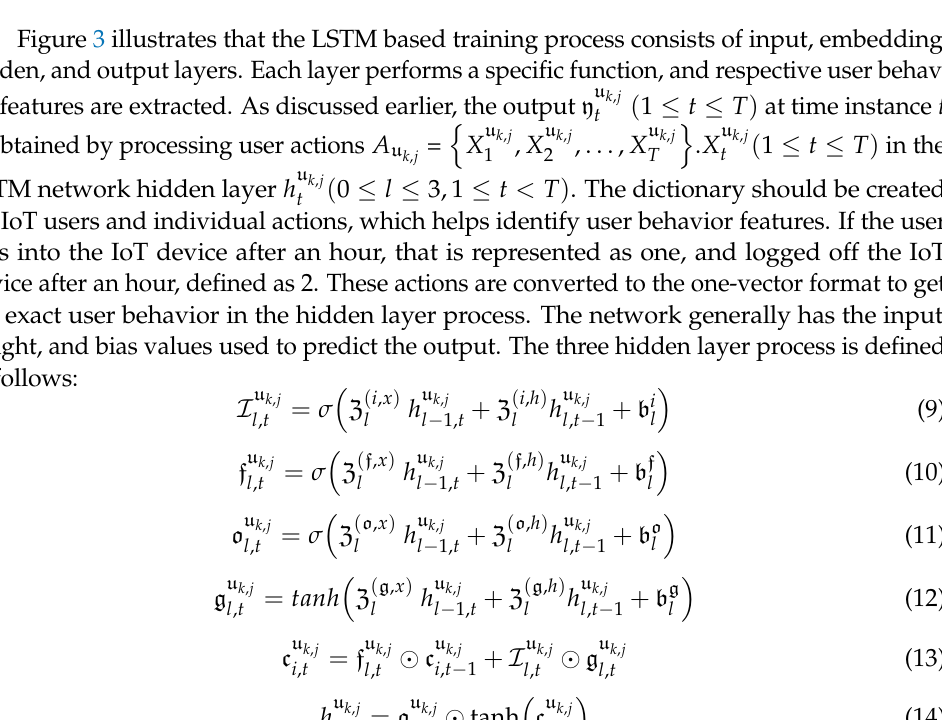
Figure 3. Intruder actions training using long-short term network.